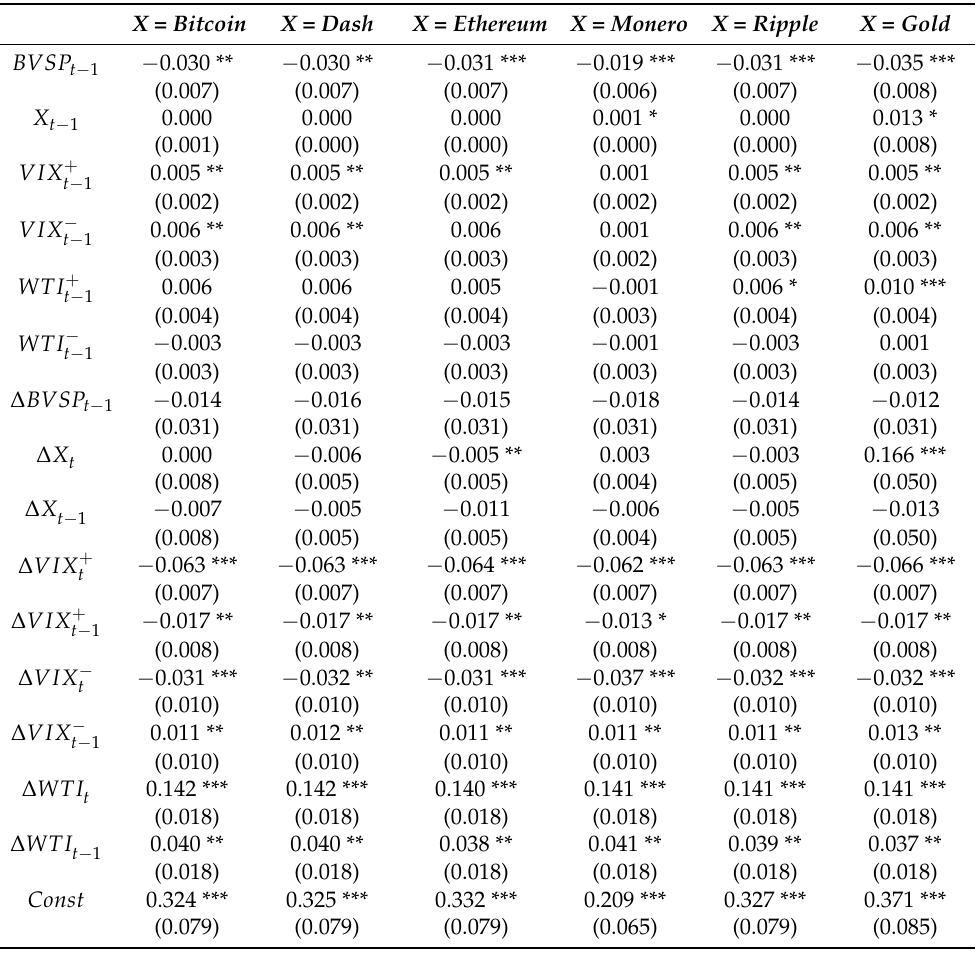
Table 6. Estimation results for BSVP before COVID-19.